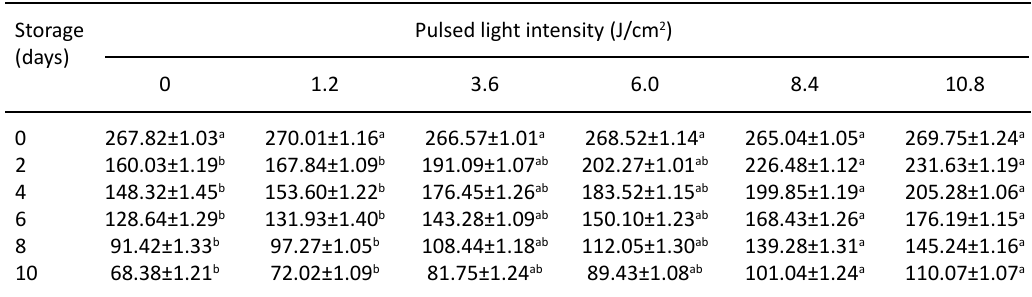
table 7. Total phenolic content (mg GAE/100 g) of Chinese kale affected by pulsed light intensity (J/cm 2 ) Storage Pulsed light intensity (J/cm 2